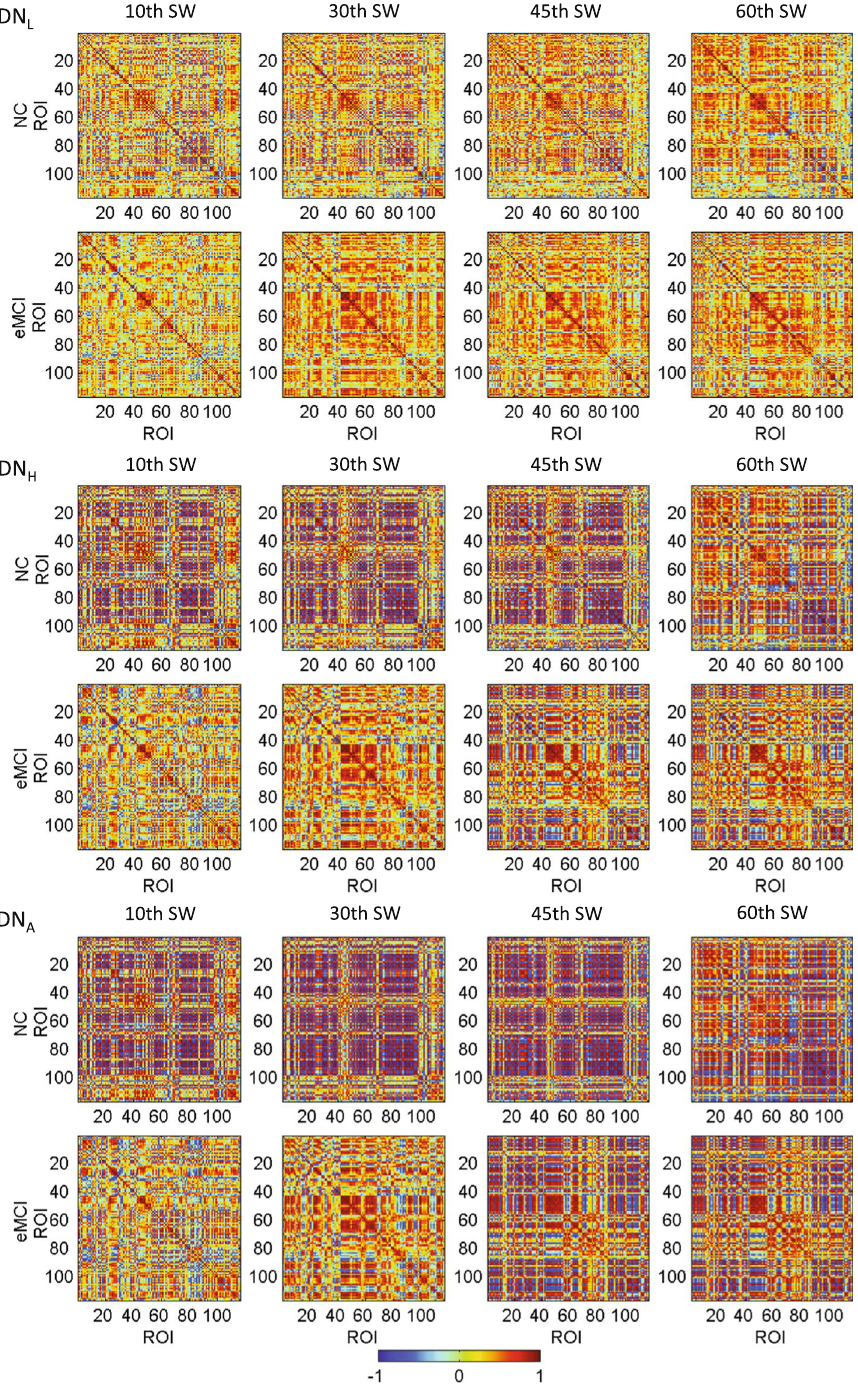
Figure 5. Respective FC matrices of DN L , DN H , and DN A from one NC subject and one eMCI subject at the 10- th, 30-th, 45-th and 60-th sliding windows (SW). The NC and eMCI subjects are randomly selected from each group. DN L : dynamic low-order FC network; DN H : dynamic high-order FC network; DN A : dynamic associated high-order FC network. Please note that we intend to show the network pattern changes along time, but not mean to compare the network pattern at a specific sliding window between two